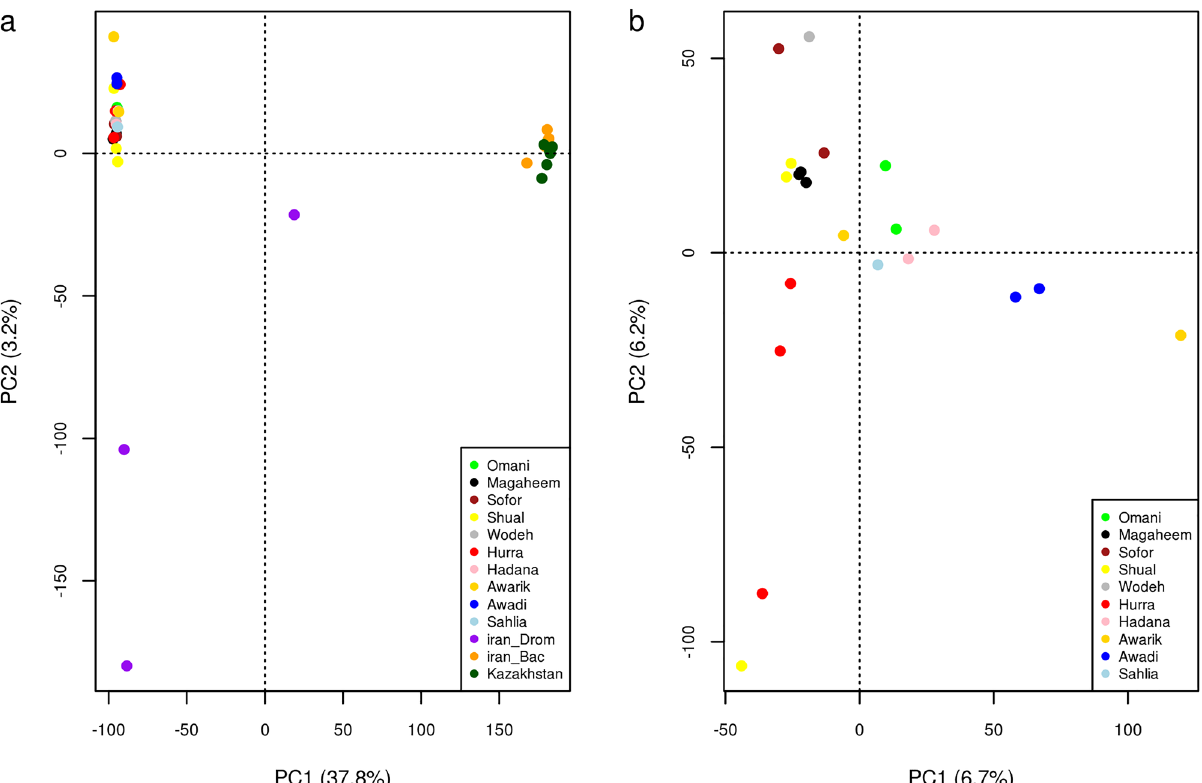
Figure 1. Principle component analysis (PCA) plots on ( a ) dromedary and Bactrian camels and ( b ) dromedary camels from the Arabian